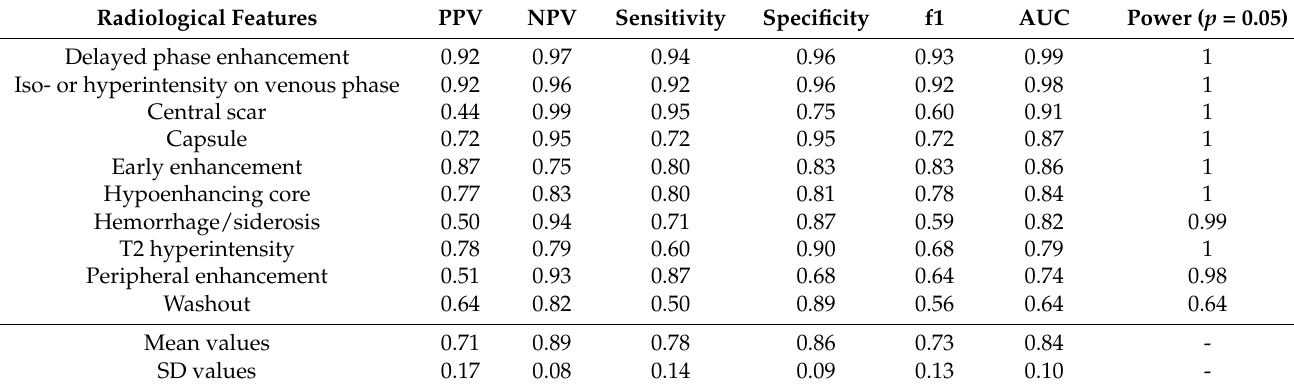
Table 3. Test dataset metrics and statistical power calculation.